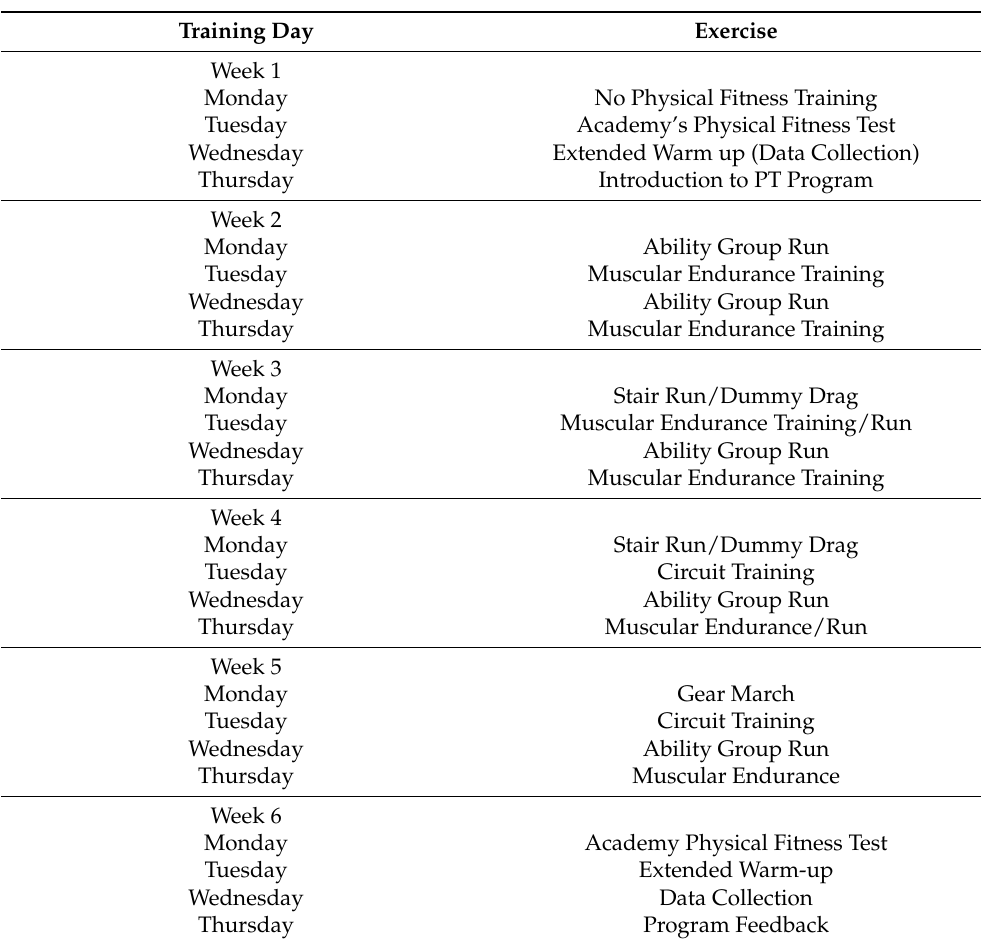
Table 3. Previous Academy Daily Training Tentative